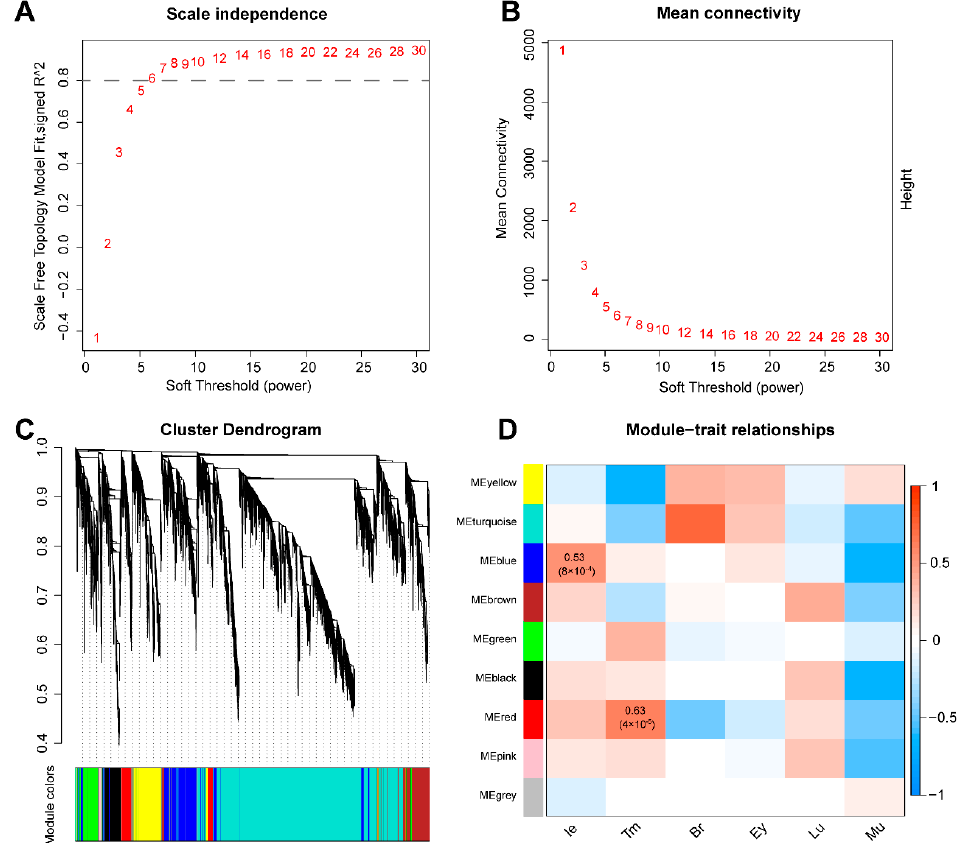
Figure 2. Co-expression analysis of all genes in the six tested tissues. ( A , B ) Analysis of soft-thresholding powers based on ( A ) scale independence and ( B ) mean connectivity. ( C ) Cluster dendrogram of genes. Modules with high similarity were merged. ( D ) Heatmap of correlation between modules and traits. The color scale shows the strength of correlation (Br: brain; Ey: eye; Ie: inner ear; Lu: lung; Mu: muscle; Tm: tympanic membrane).